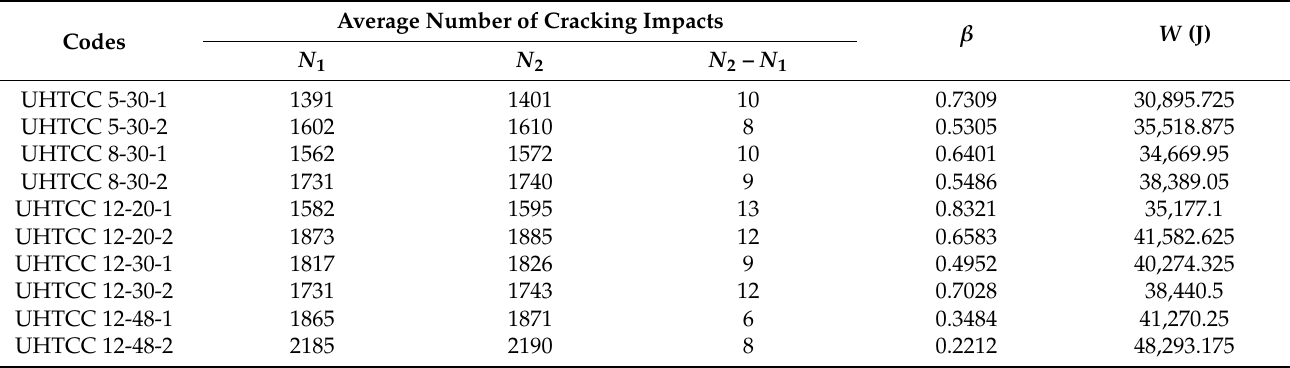
Table 5. Analysis of the impact resistance index of UHTCC